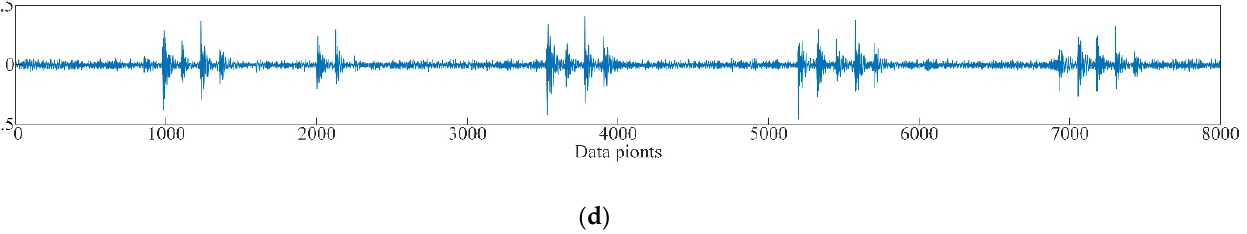
Figure 12. Time-domain waveform of the vibration signals of bearings with different faults, ( a ) normal bearings, ( b ) inner ring cracked bearings, ( c ) outer ring cracked bearings, ( d ) roller cracked bearings.